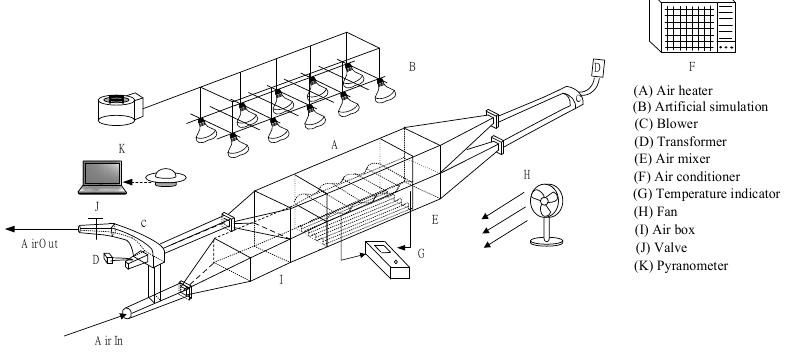
Figure 10. Experimental setup of a recycling cross-corrugated solar air collector ( Type D ).